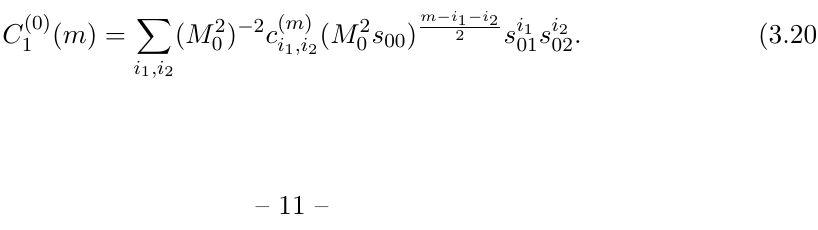
Figure 1 . Algorithm for the calculation of the expansion coefficients of tadpole coefficients of tensor bubble integral. Here each point ( i, m ) represents an expansion coefficient c ( m ) represented by black squares are the zero expansion coefficients, while the points represented by blue or red circles are the unknown expansion coefficients we need to calculate. The red thick arrow represents the recurrence relation (3.12), the orange thick arrows represents the recurrence relation (3.9), and the cyan thick arrow represents the recurrence relation